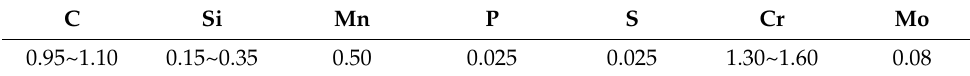
Table 1. Chemical composition of the SUJ2Z (%).